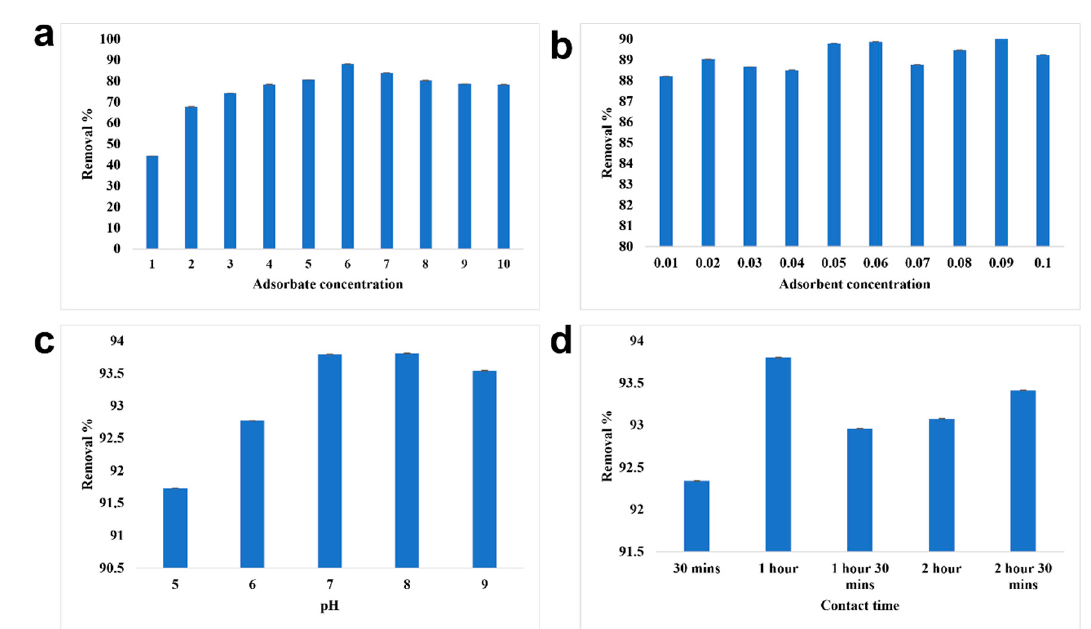
Figure 7. Batch adsorption study of SPIONs. ( a ) Optimization of adsorbate concentration, ( b ) Optimization of adsorbent concentration, ( c ) Optimization of pH, ( d ) Optimization of contact time.